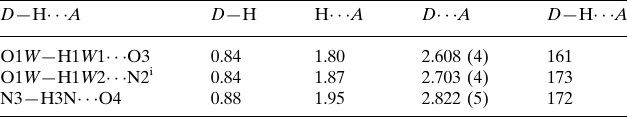
Hydrogen-bond geometry (A˚ , (cid:2)